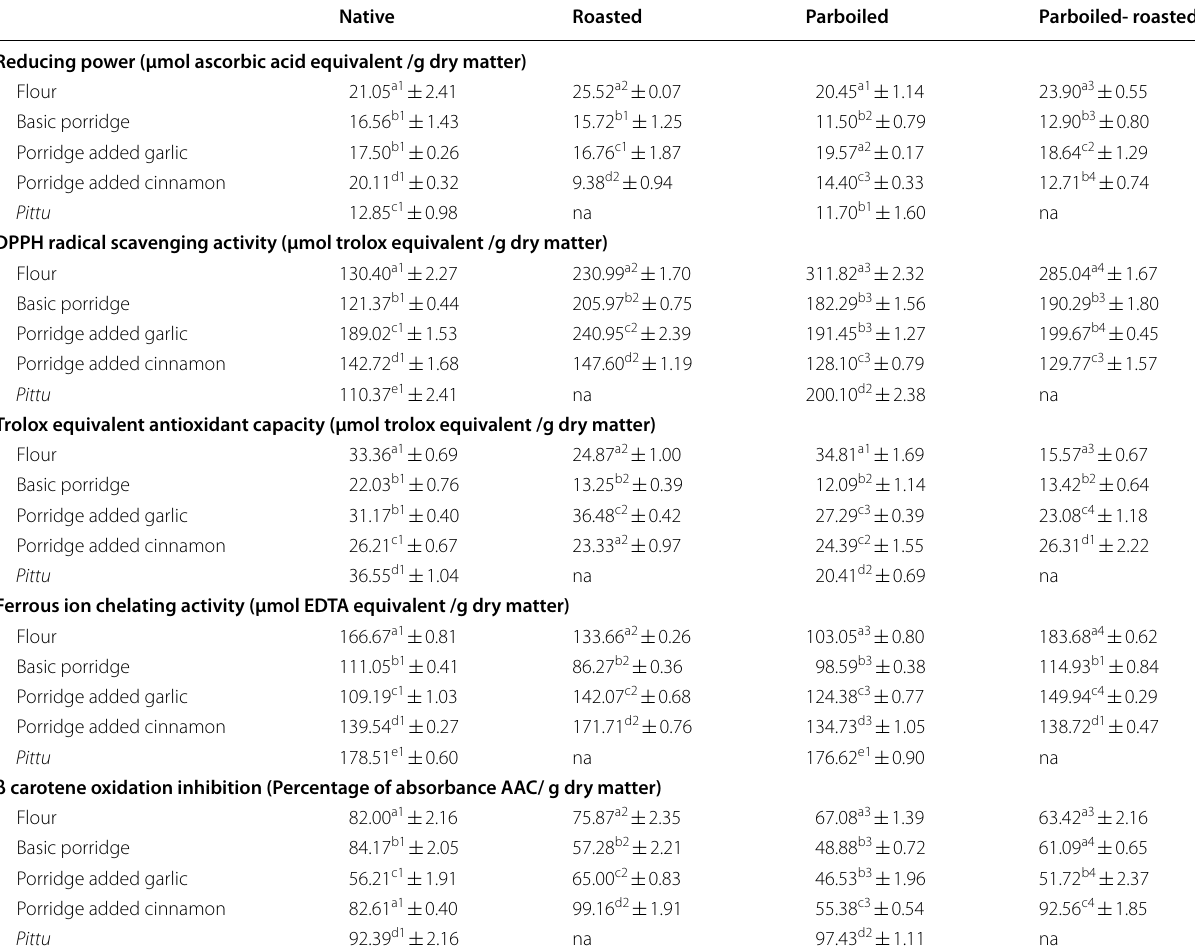
Table 3 Antioxidant activities of finger millet flour, and food subjected to different processing conditions